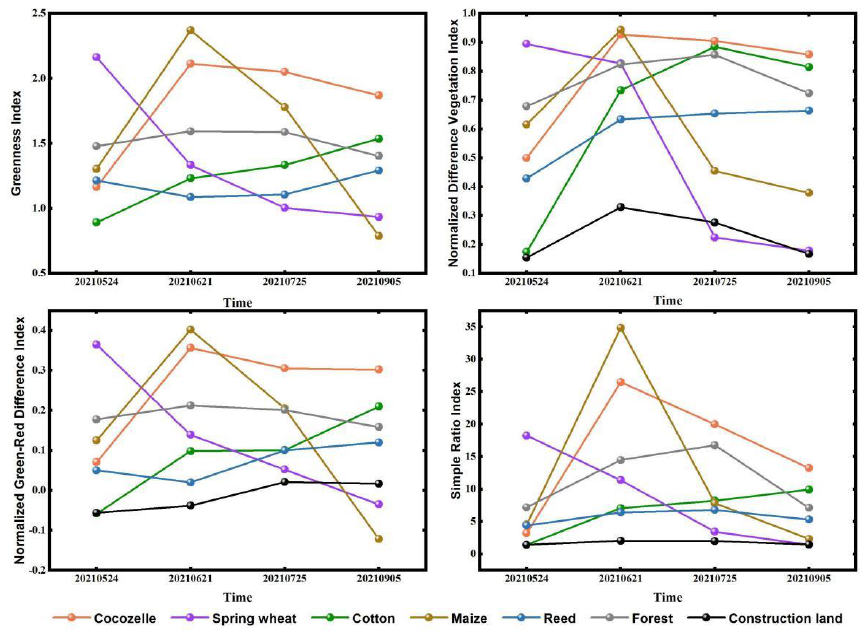
Figure 6. Average vegetation index of different crops based on time-series images.